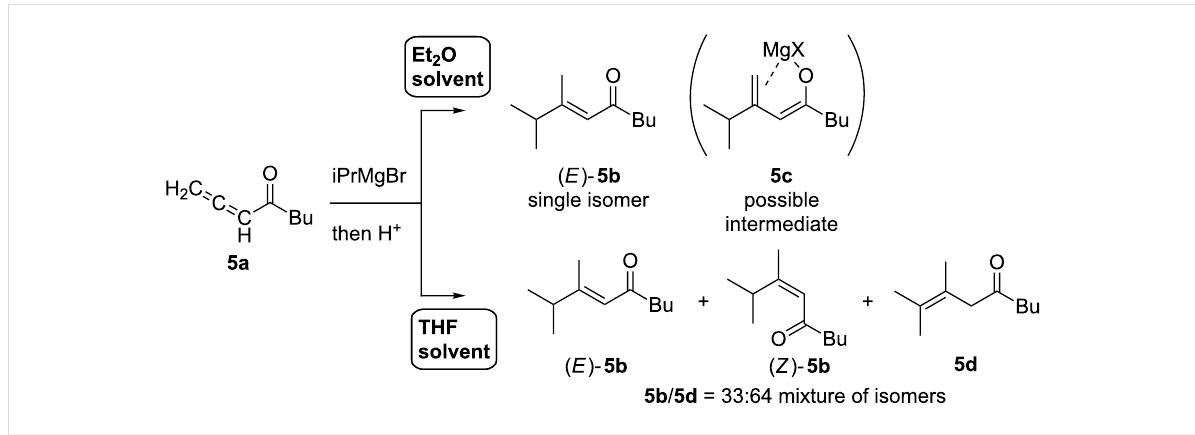
Scheme 46: Reaction of allenyl ketones with organomagnesium reagent.